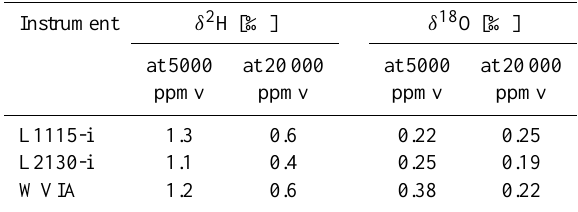
Table 5. Standard deviation of laser spectroscopic isotope